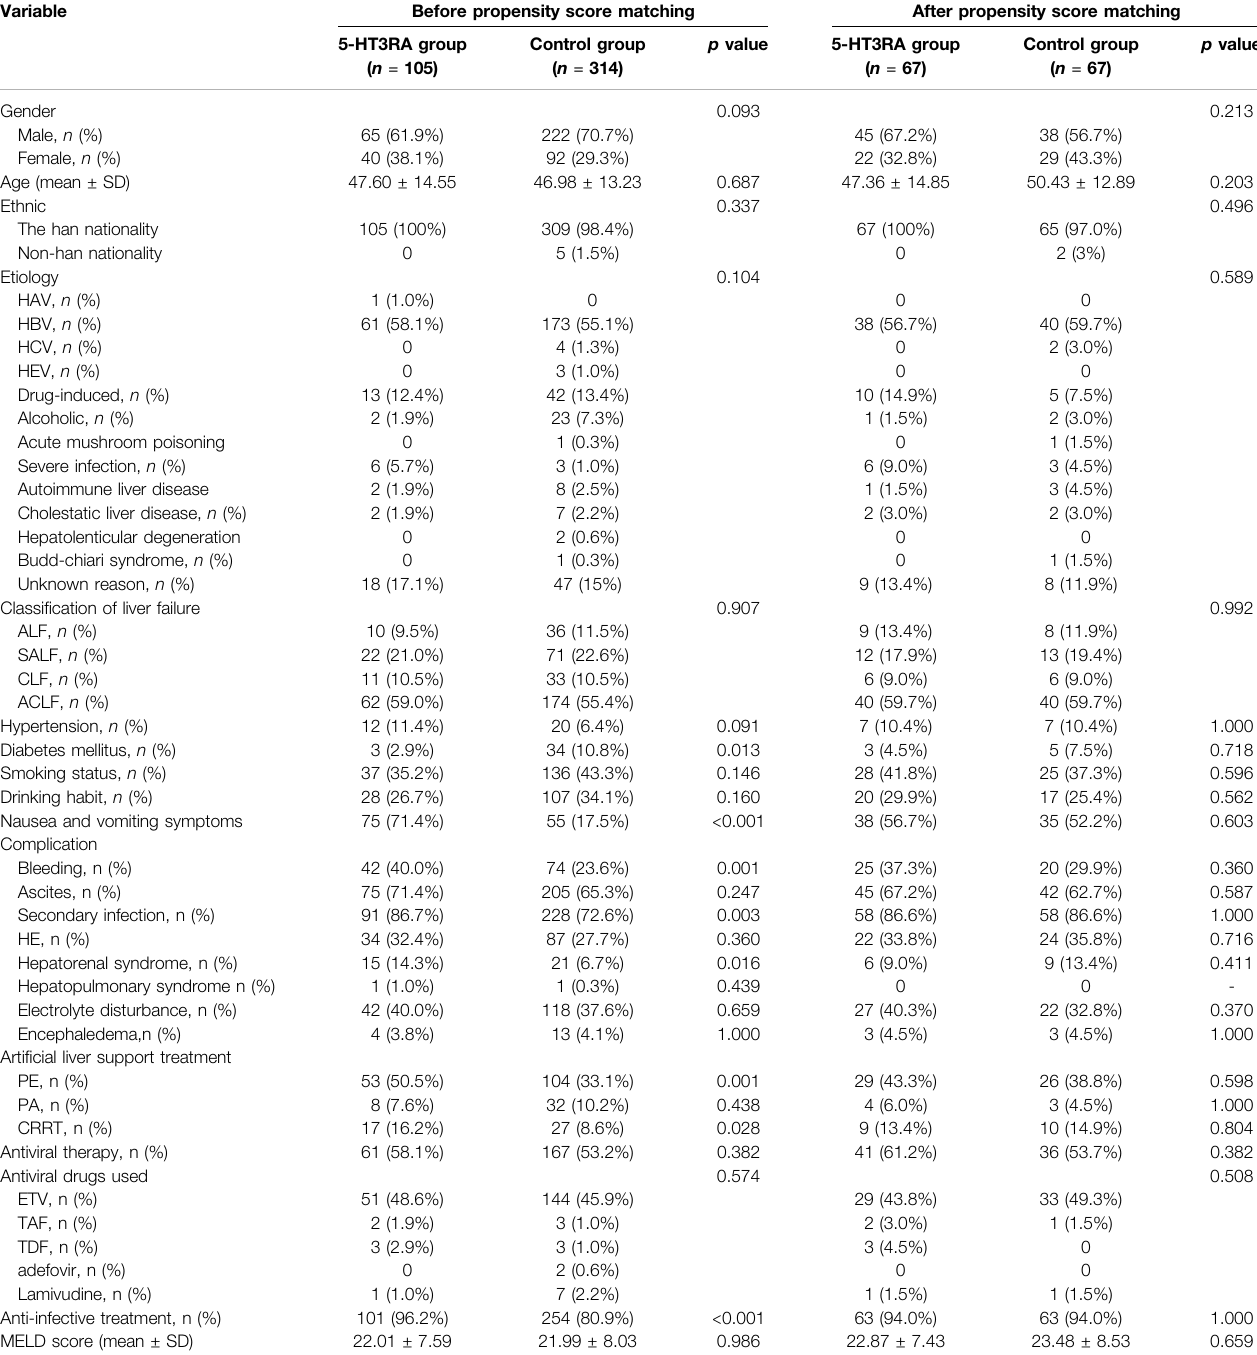
TABLE 1 | Baseline characteristics in patients with and without the use of 5-HT3 receptor antagonists. Variable Before propensity score